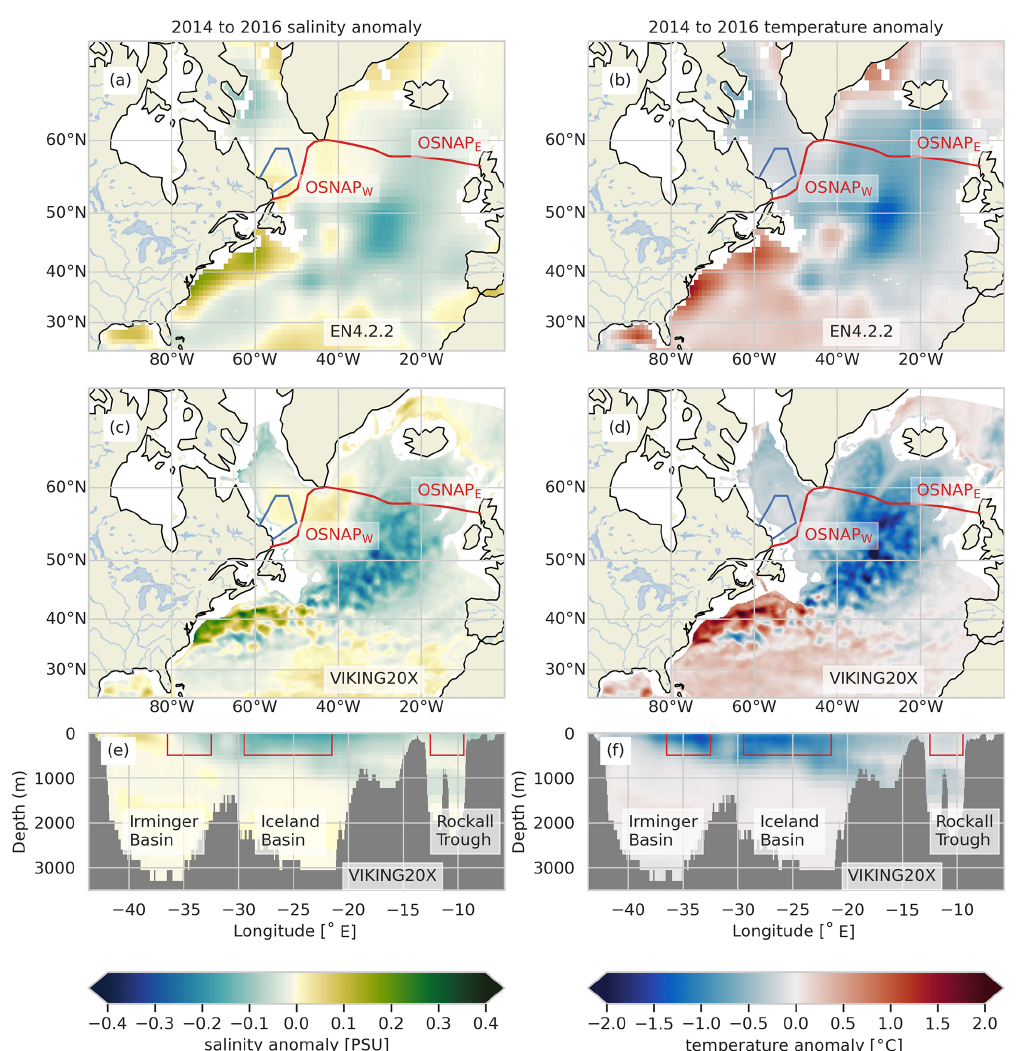
Figure 1. The 2014–16 mean (a, c) salinity and (b, d) temperature anomalies, relative to the 2004–2019 mean, in the upper 500m from the (a, b) EN4 dataset and (c, d) VIKING20X model. The OSNAP (Overturning in the Subpolar North Atlantic Programme) observational section ( e, f and red lines in a – d ), occupied since 2014 and used here to spawn tracked particles in VIKING20X, traverses the fresh patch in the Iceland and Irminger basins. In 2014–2016 there is a widespread region of fresher than average water in the upper 500m of the eastern subpolar gyre, with a “compensating” region of raised salinity on the North West Atlantic Continental Shelf and Slope region (NWACSS, 40–50 ◦ N, 50–70 ◦ W, which includes offshore Slope Sea deep water north of the Gulf Stream). The blue polygon in the Labrador Sea outflow region (a–d) shows the region used for comparison with observations of isopycnal depths (Sect. 6.3). Vertical red lines in (e, f) show the positions of the time series in Fig.